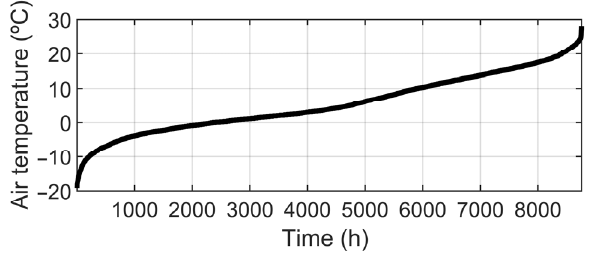
Figure 6. Duration curve of air temperature in Oulu 2020 [48].